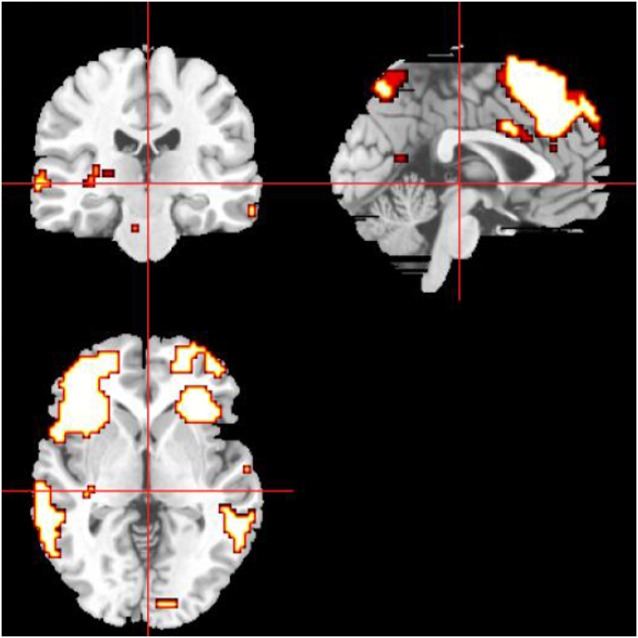
The mask of the CEN, mainly including the ACC and bilateral dorsolateral PFC (dlPFC).